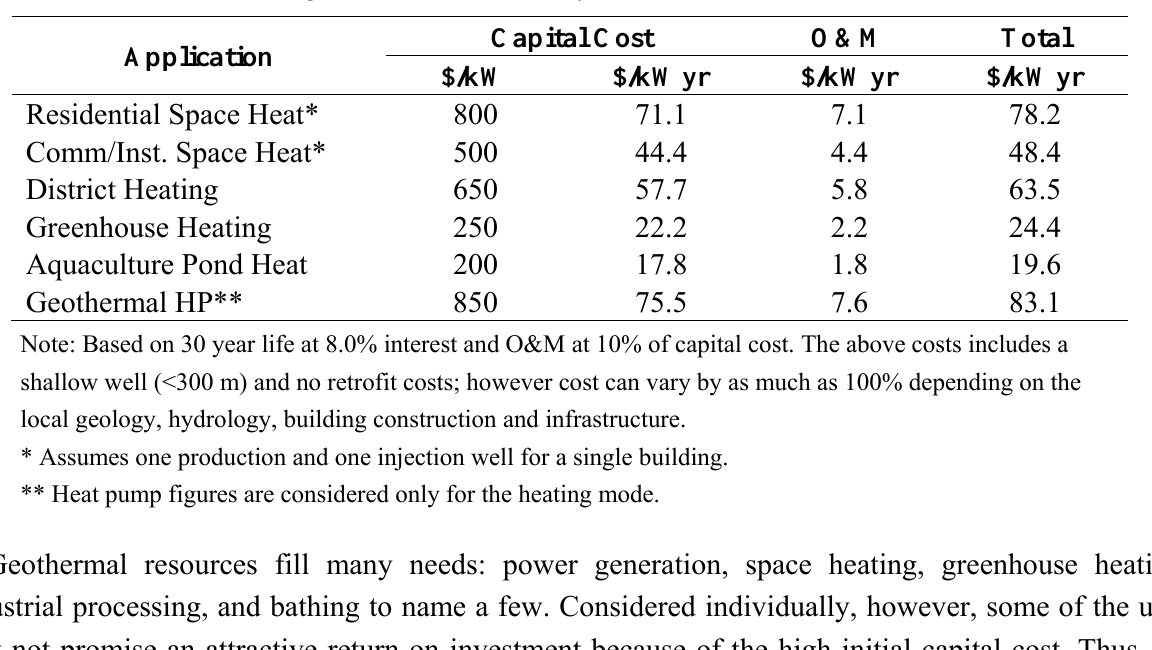
Table 3. Average costs of direct-use systems in the United States for